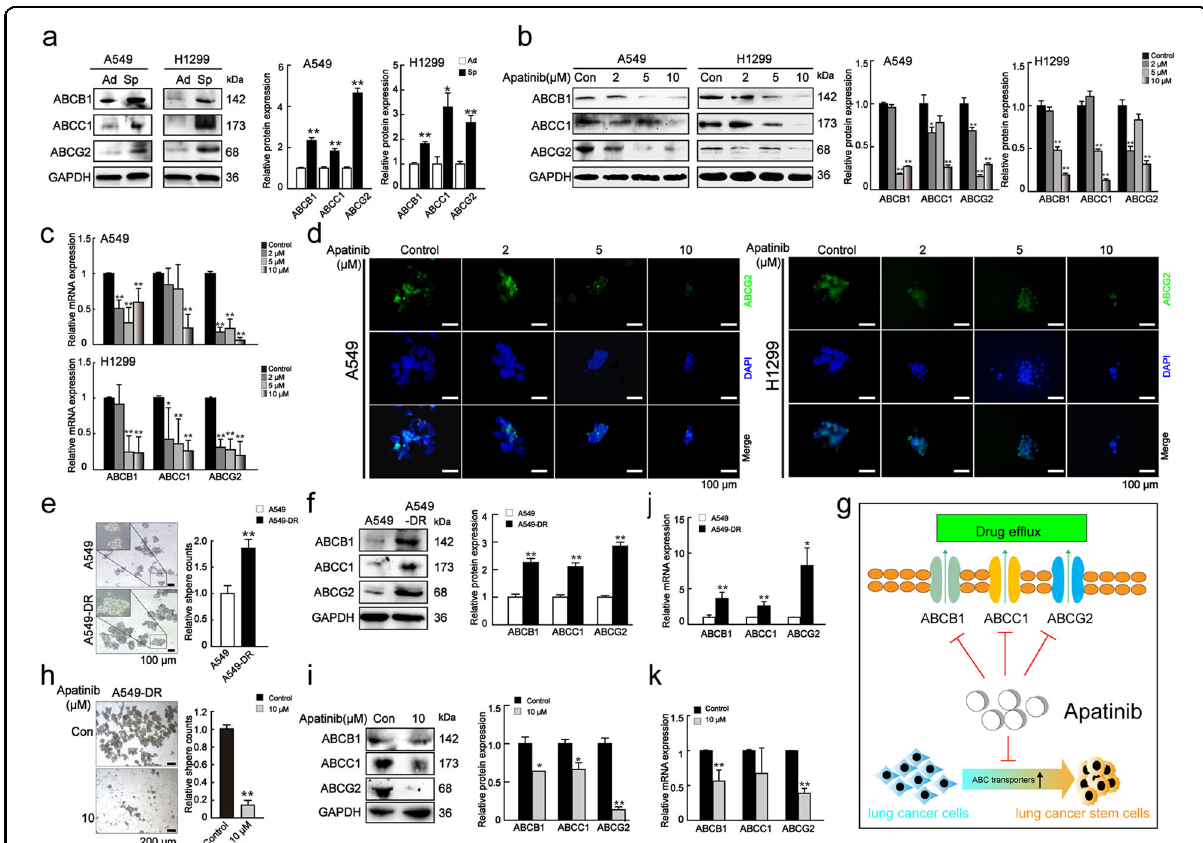
Fig. 2 Apatinib decreased drug resistance-related genes. a Protein levels of drug resistance-related genes (ABCB1, ABCC1, and ABCG2) in adherent cells and spheroids. Ad adherent cells, Sp spheroids. Data are presented as mean ± SD ( n = 3). * p < 0.05, ** p < 0.01 compared to the control group. b Protein levels of drug resistant-related genes in spheroids on day 7 after apatinib treatment. One-way ANOVA (Bonferroni ’ s multiple- comparison test) was used. Data are presented as mean ± SD ( n = 3). * p < 0.05, ** p < 0.01 compared to the control group. c mRNA expression of drug resistant-related genes in spheroids on day 7 after apatinib treatment. One-way ANOVA (Bonferroni ’ s multiple-comparison test) was used. Data are presented as mean ± SD ( n = 3). * p < 0.05, ** p < 0.01 compared to the control group. d Representative immuno fl uorescence images of ABCG2 (green) in apatinib-treated spheroids. DAPI: blue. Scale bar = 100 μ m. e . Sphere-forming capacities of A549 and CDDP-resistant A549 cells (A549-DR) group. f , j Protein and mRNA levels of drug resistance-related genes in A549 and A549-DR cells on day 7. One-way ANOVA (Bonferroni ’ s